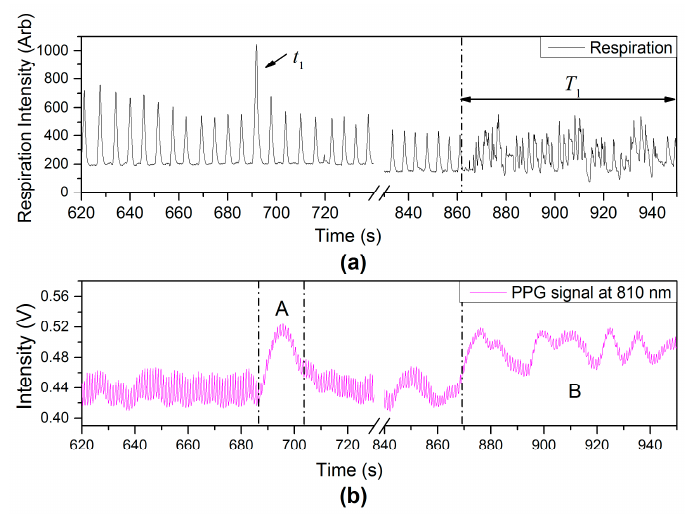
Figure 14. ( a ) Respiration including deep breathing and talking events and ( b ) PPG signal.